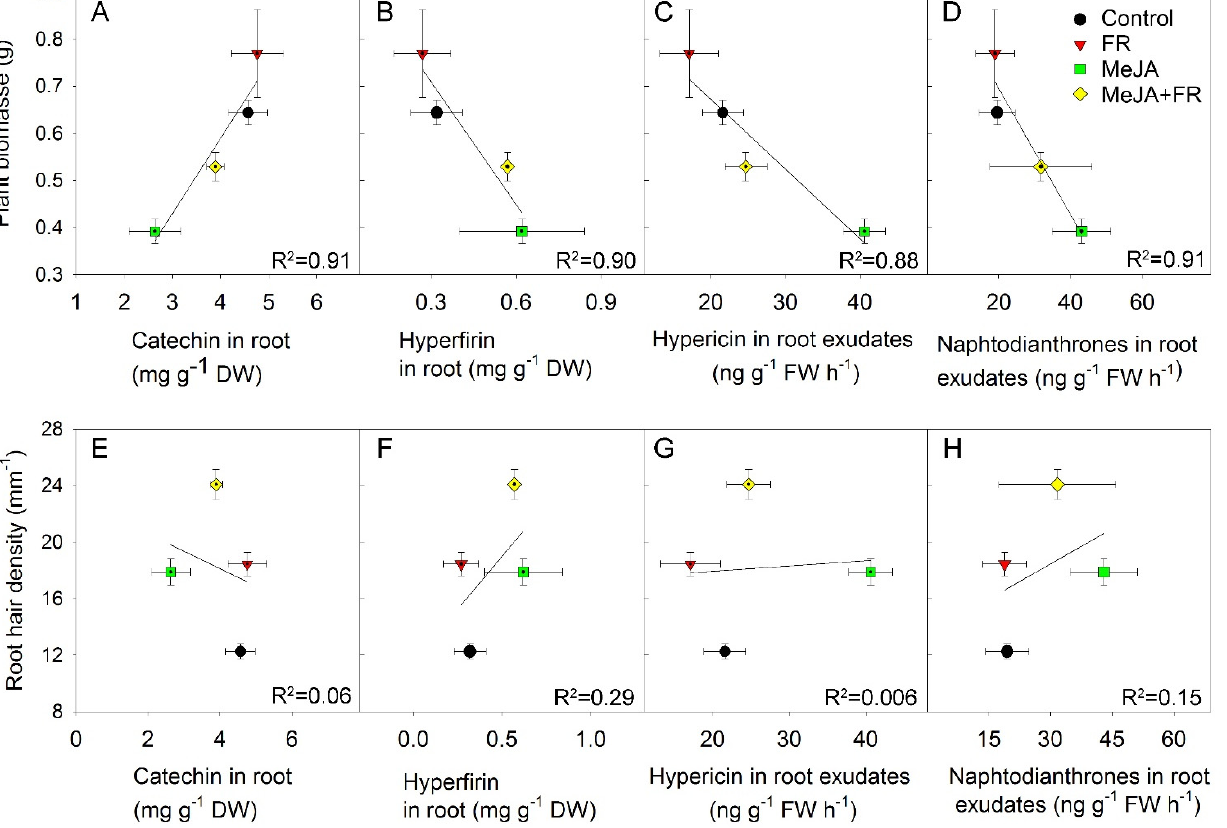
Figure 8. The relationship between plant biomass of Hypericum perforatum and catechin ( A ) and hyperfirin ( B ) concentrations in roots, as well as hypericin ( C ) and other naphtodianthrones ( D ) in root exudates. The relationship between root hair density and catechin ( E ) and hyperfirin ( F ) concentrations in roots as well as hypericin ( G ) and naphtodianthrones ( H ) in root exudates.